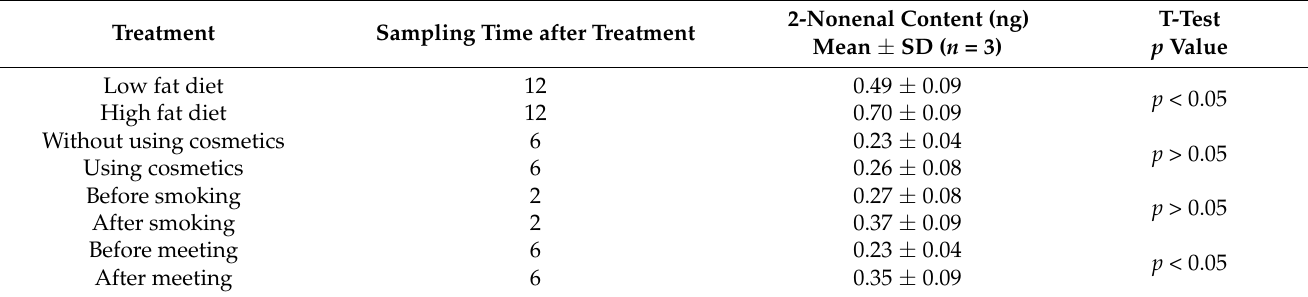
Table 3. 2-Nonenal contents detected in body odor samples in various life styles.